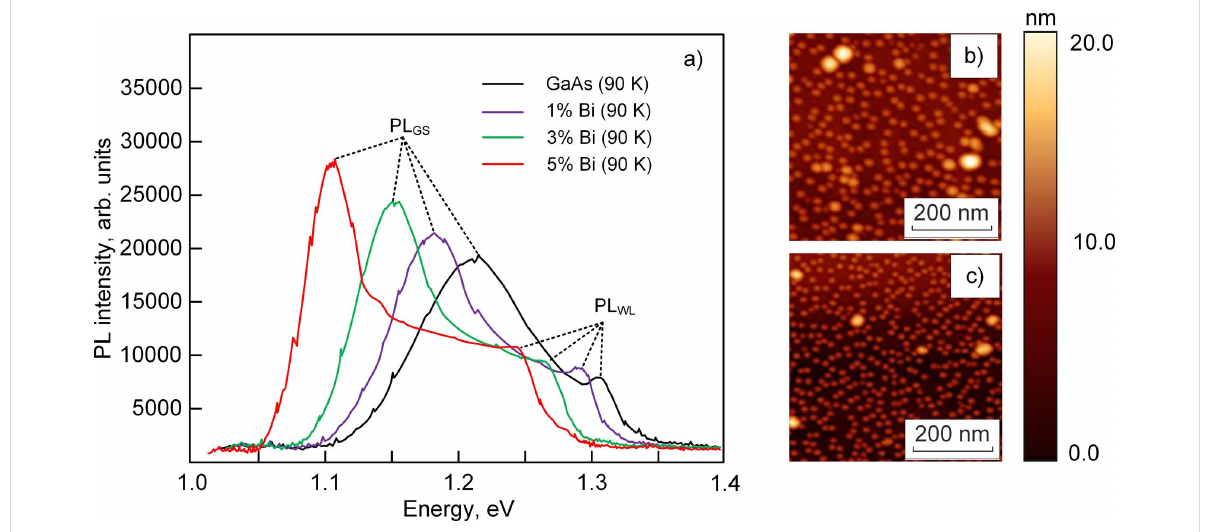
Figure 4: a) Photoluminescence spectra of InAs/GaAs heterostructures with different Bi content; b) Atomic force microscopy images of the morpholo- gy of InAs QDs on GaAs 0.95 Bi 0.05 ; c) Atomic force microscopy images of the morphology of InAs QDs on GaAs.